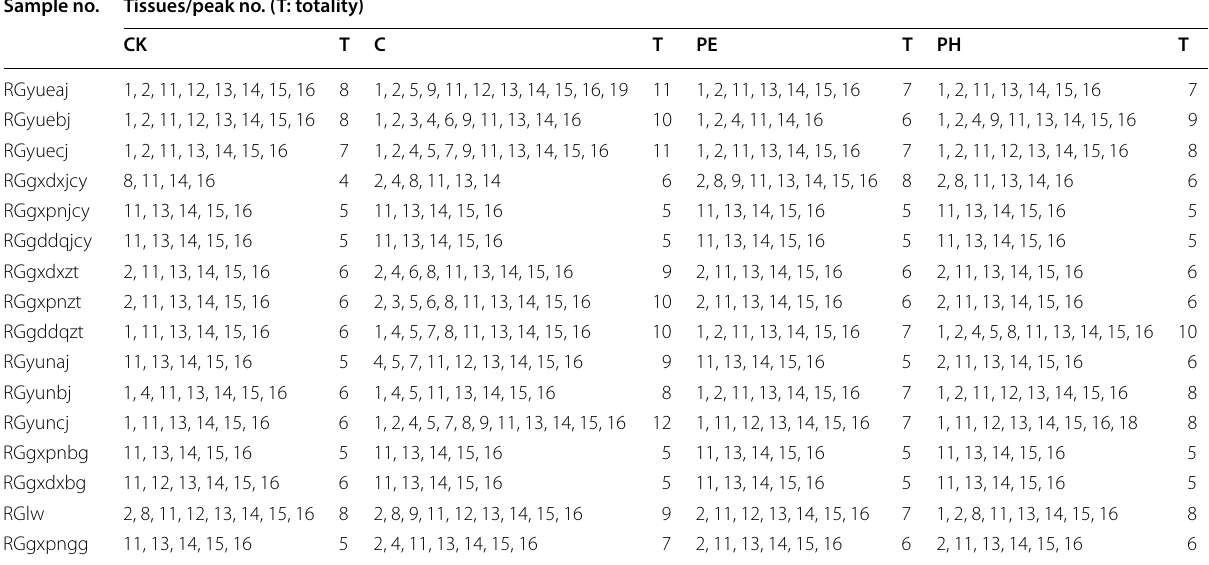
Table 3 The chromatographic peaks found in the chromatograms of each tissue in different specifications of cinnamon Sample no. Tissues/peak no. (T: totality)